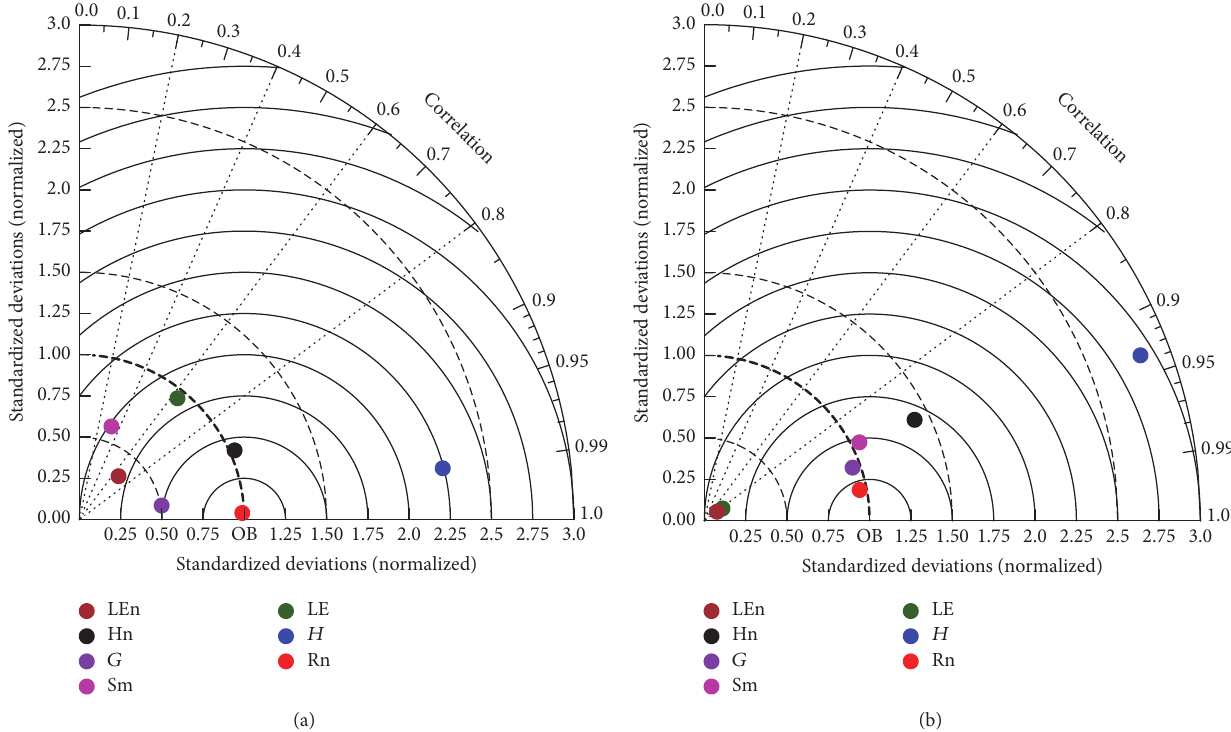
Figure 4: Statistical comparison between the simulated and observed variables for (a) the dry period and (b) the wet period at the study